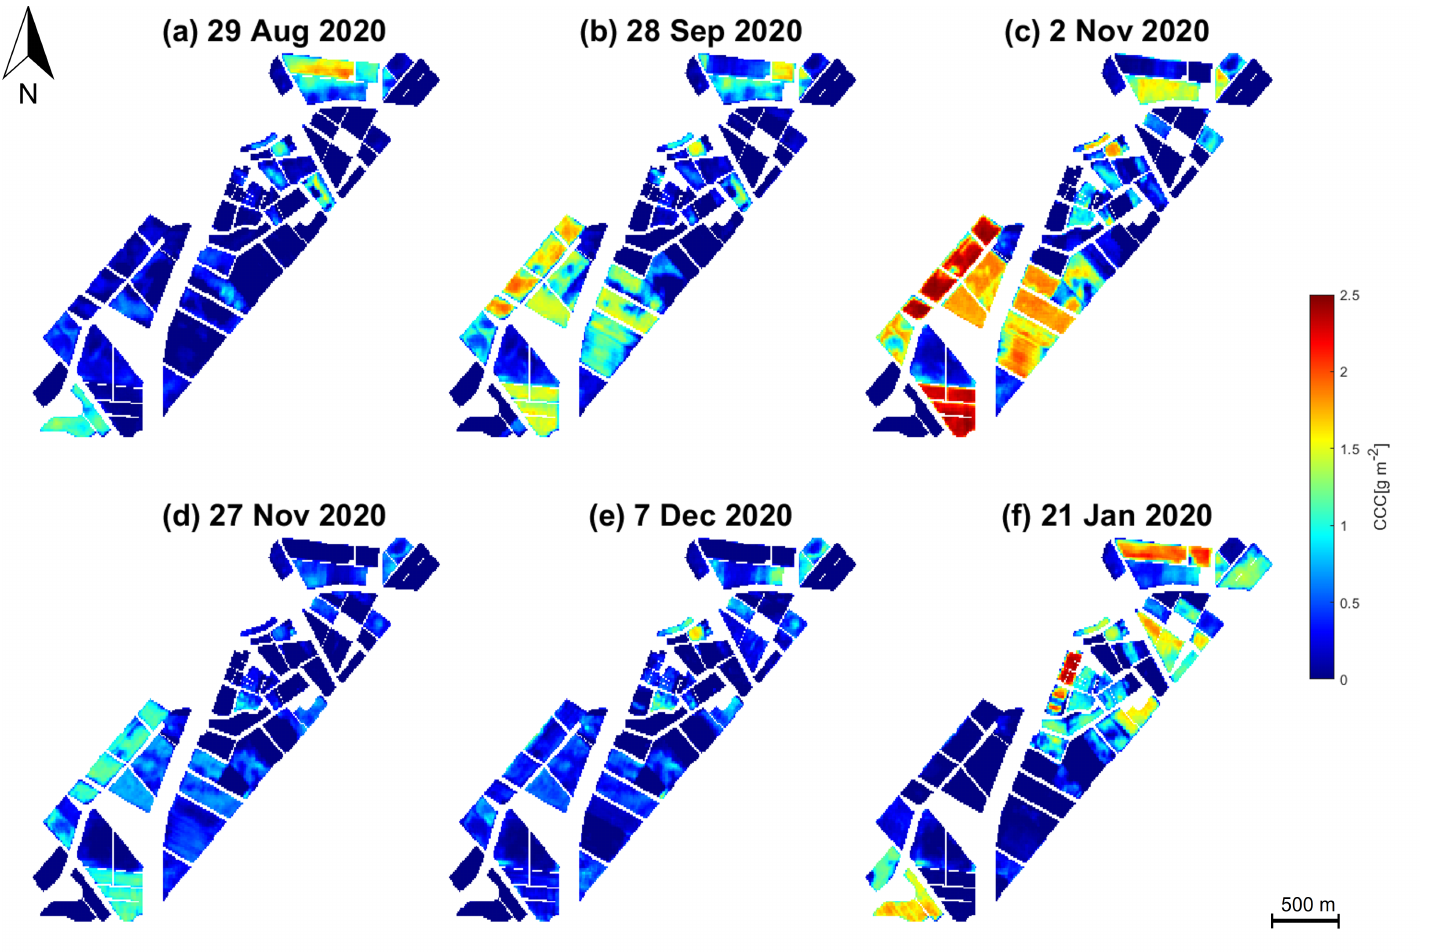
Figure 8. CCC[g m − 2 ] of different crops in the study site, retrieved by the GPR model using simulated vegetation reflectance spectra, in-situ biophysical/biochemical measurements and S2 surface multi-spectral reflectance data. Data obtained from BVCR wheat campaign 2020. ( a ) wheat tillering stage at 29 August 2020; ( b )